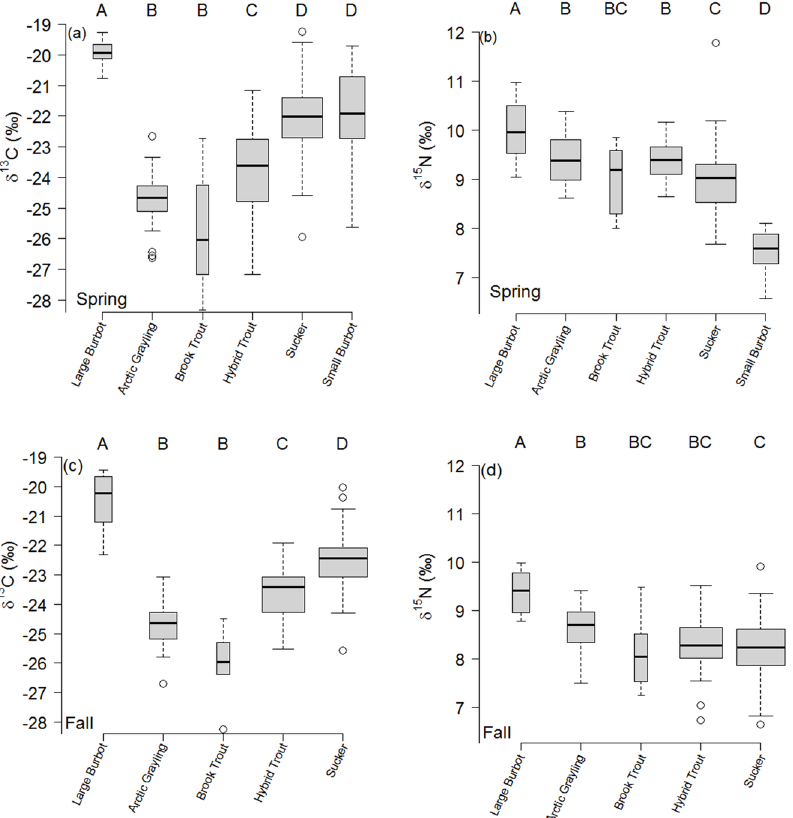
Fig 4. Boxplots indicating isotopic comparison for spring (a and b) and fall (c and d) of 2011 and 2012. The horizontal line depicts average isotope values, boxes indicate standard errors, and the whiskers indicate standard deviation. Dots represent outliers. Unique letters represent significant differences determined by Tukey Honestly Significant